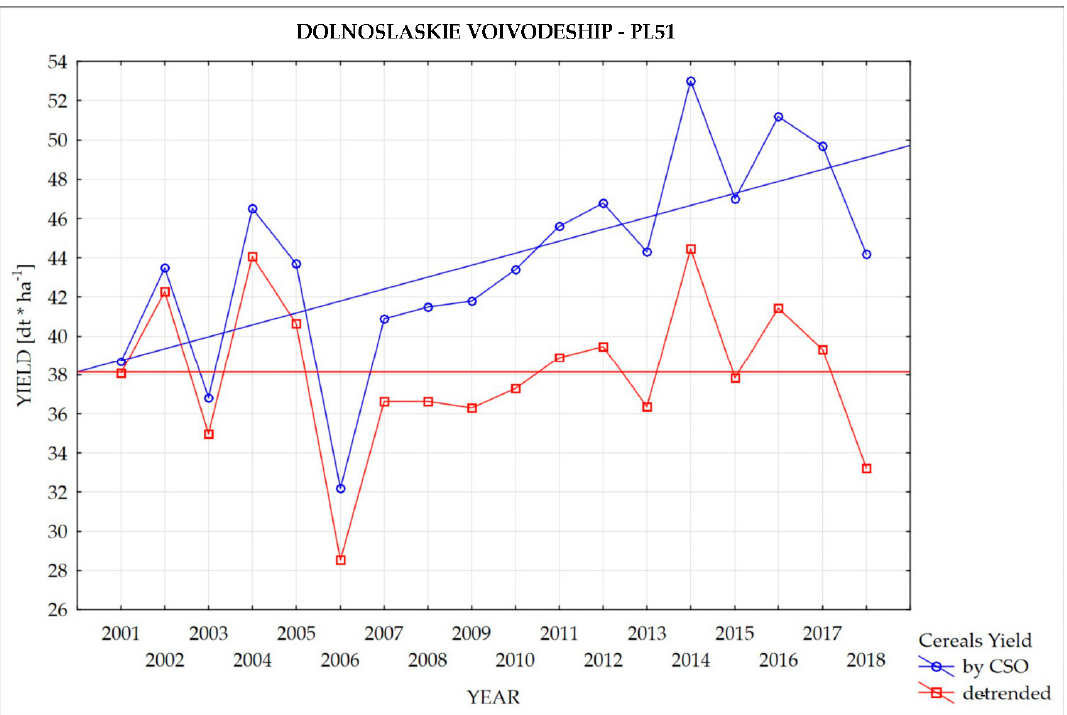
Figure 20. Cereal yield before and after de-trending procedure—NUTS 2 PL51.